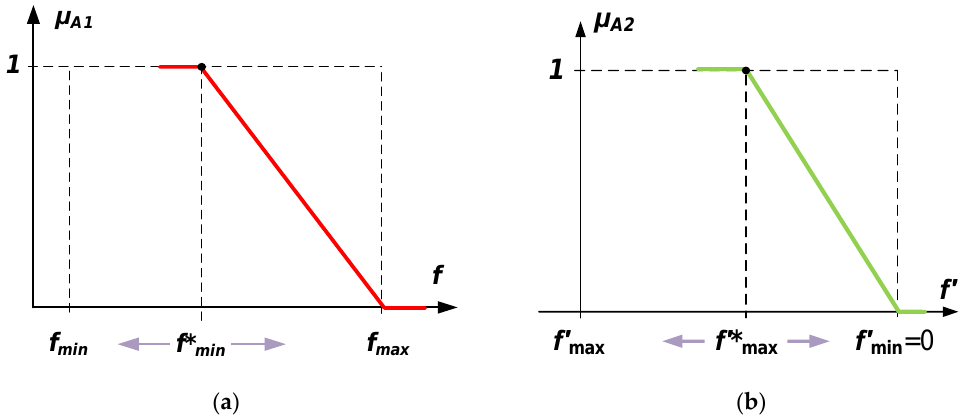
Figure 3. Membership functions used in the proposed algorithm: ( a ) low frequency, ( b ) high rate of frequency change.